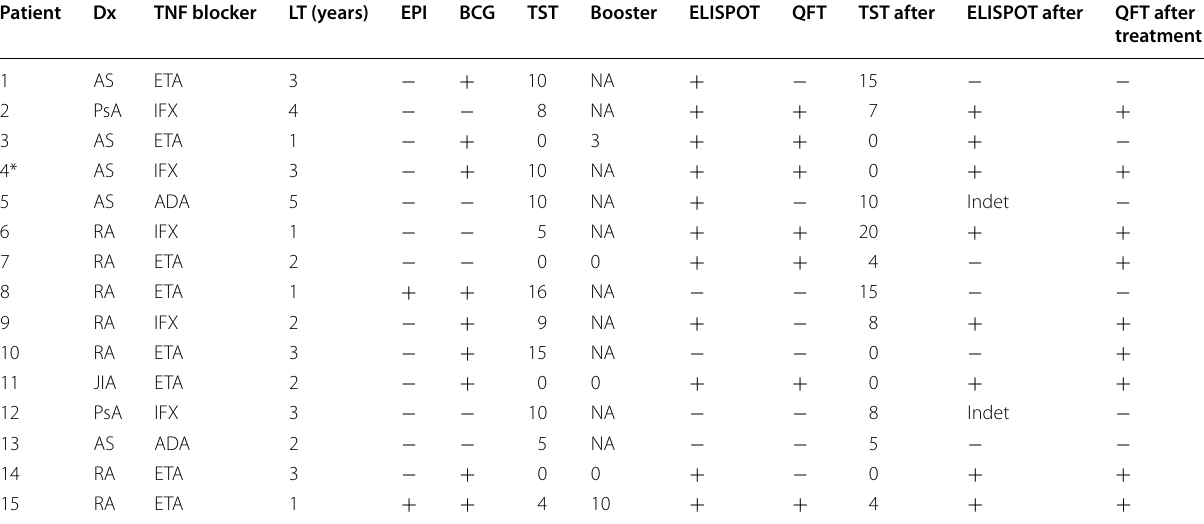
* Patient diagnosed with pulmonary TB before and after treatment RA, rheumatoid arthritis; AS, ankylosing spondylitis; PsA, psoriatic arthritis; JIA, juvenile idiopathic arthritis; TNF, tumor necrosis factor blockers; ADA, adalimumab; IFX, infliximab; ETA, etanercept; Dx, diagnosis; LT, length of treatment (in years); EPI, epidemiology; BCG, Bacillus Calmette-Guérin; TST, tuberculin skin test (in mm); QFT, Quantiferon, NA, not available; Indet, indeterminate